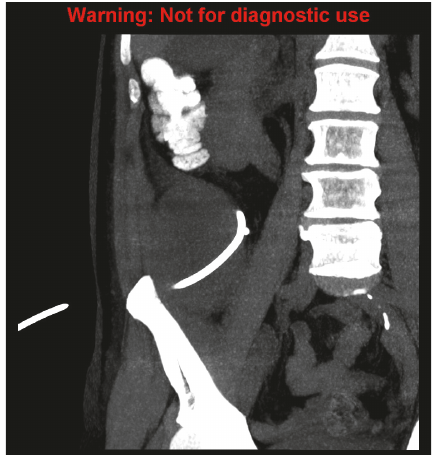
Figure 3: Thickened and inflamed appendix with a focal perforation of the tip with an adjacent abscess.